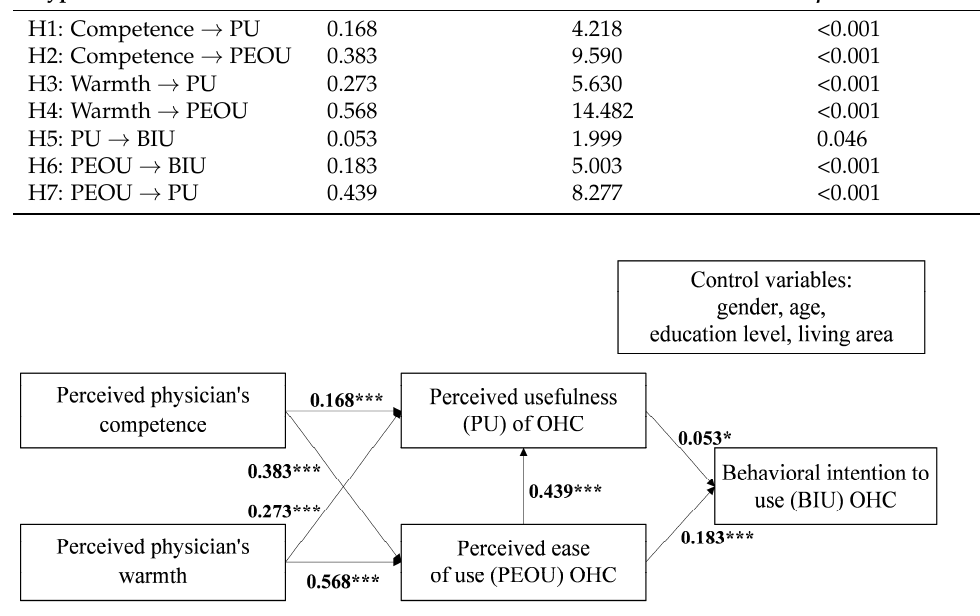
Figure 2. Research model with path coefficients. *** p < 0.001; * p < 0.05.